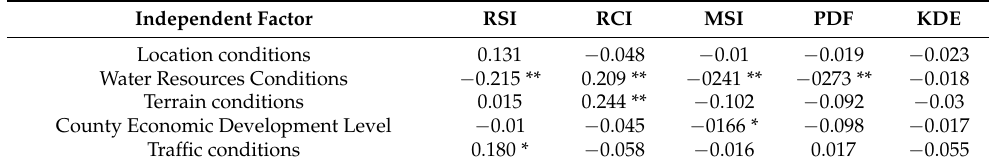
Table 4. The relationship between landscape indicators and variables in rural settlements. Independent Factor RSI RCI MSI PDF KDE Location conditions